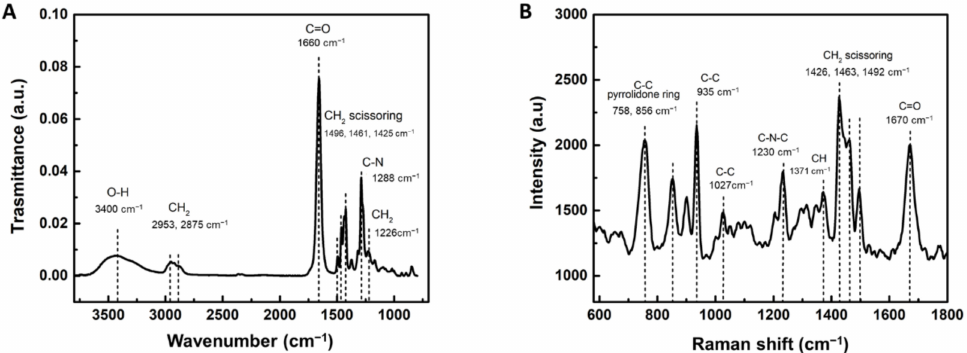
Figure 1. Chemical analysis of PVP hydrogel by ( A ) FTIR and ( B ) Raman spectroscopies. Raman spectrum of PVP hydrogel is shown in Figure 1B. The intense band of carbonyl group vibration (C=O) is observed at 1670 cm − 1 . The peaks at 1492, 1463, 1426 cm − 1 are assigned to CH 2 scissoring vibration. While the peak at 1371 cm − 1 is assigned to CH group vibration. The C–N–C and C–C bands are presented at 1230 cm − 1 and 1027 cm − 1 , respectively. The peak at 935 cm − 1 is ascribed to C-C ring breathing. Also, 856 and 758 cm − 1 peaks corresponded to C-C vibrations of pyrrolidone